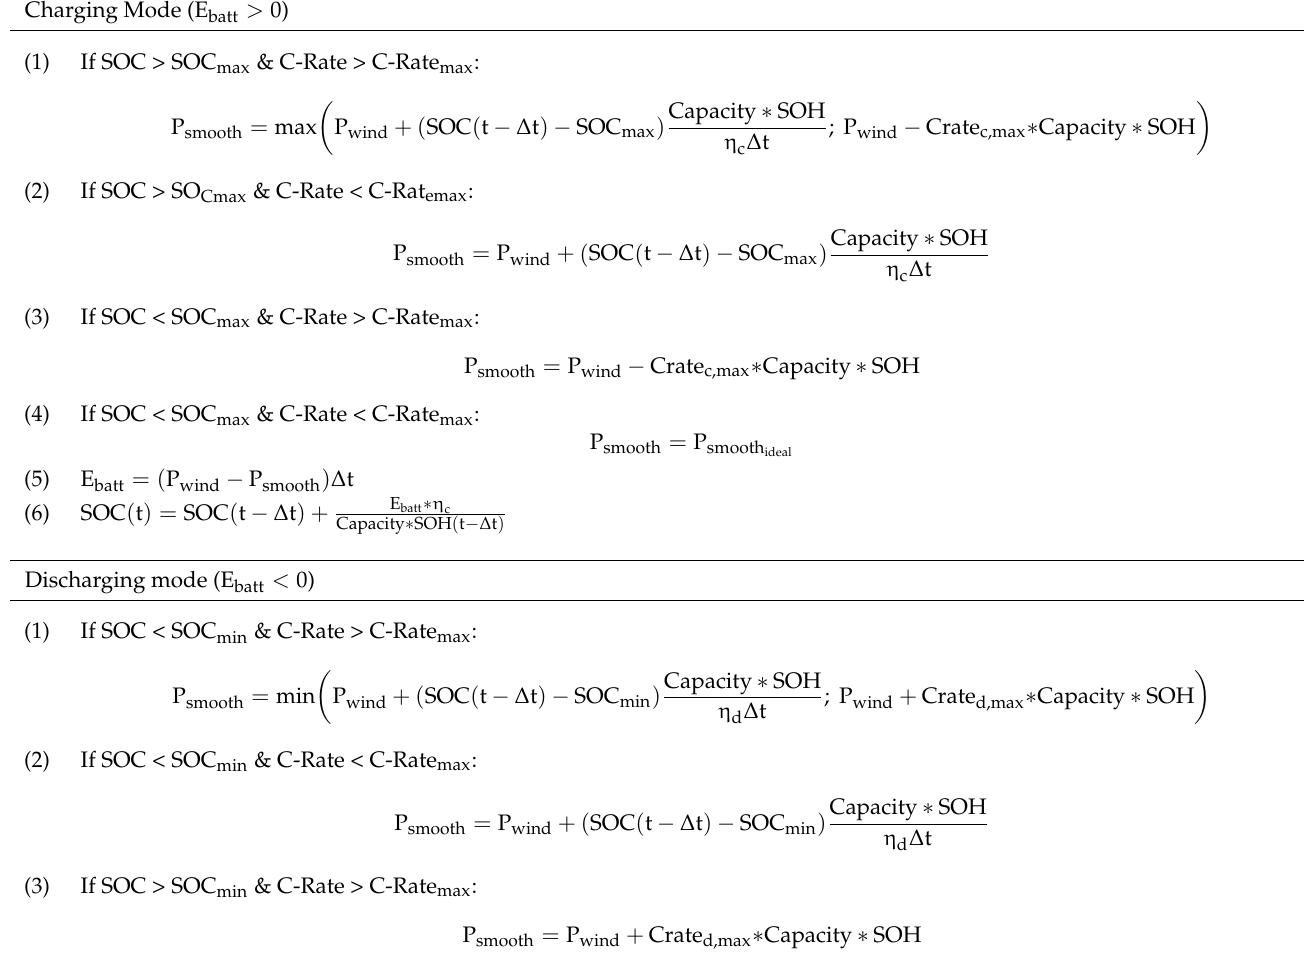
Table 4. Algorithm correction to account for battery constraints.